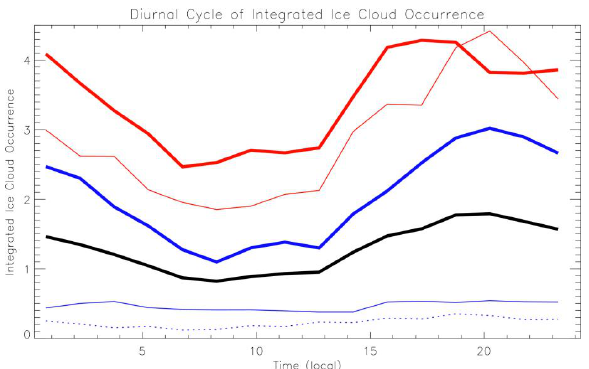
Figure 3: Time series of the vertically-integrated ice cloud occurrence over Darwin with all regimes included (thick black line), and for the following large-scale atmospheric regimes: Moist Easterly (thick blue line), Easterly (thin solid blue line), Dry Easterly (thin dotted blue line), Active monsoon (thick red line), and Shallow Westerly (thin red line).